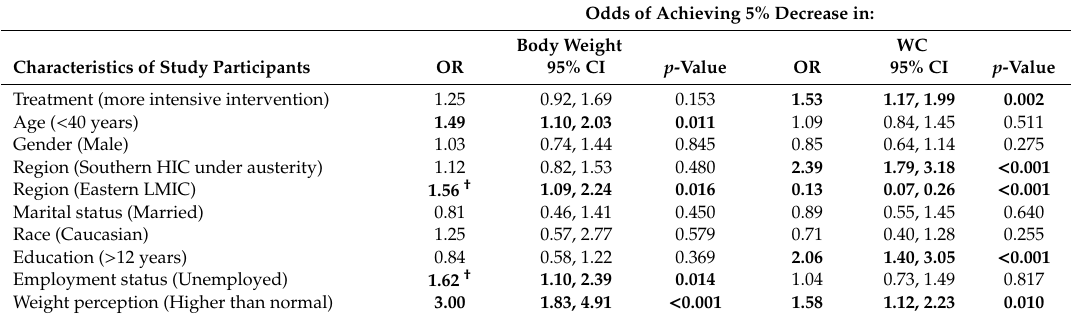
Table 3. Odds of achieving a 5% decrease in anthropometric values during the 2 years of the Feel4Diabetes program by participants’ characteristics. Odds of Achieving 5% Decrease in: Body Weight WC Characteristics of Study Participants OR 95% CI p -Value OR 95% CI p